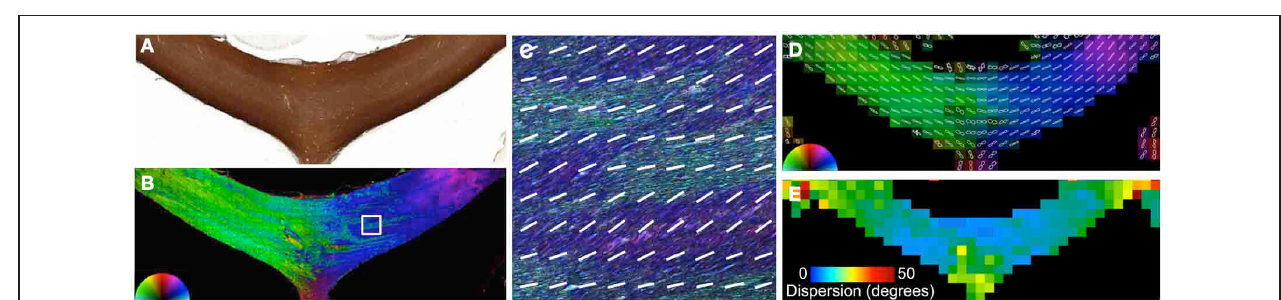
containing crossing fibers (B) . Compared to the unmodified stained sections (C) , crossing fibers were more apparent in the same images color-coded with orientation (D) . The two peaks in the FOD highlight the presence of two discrete fiber populations within this subregion of the centrum semi-ovale (E) .